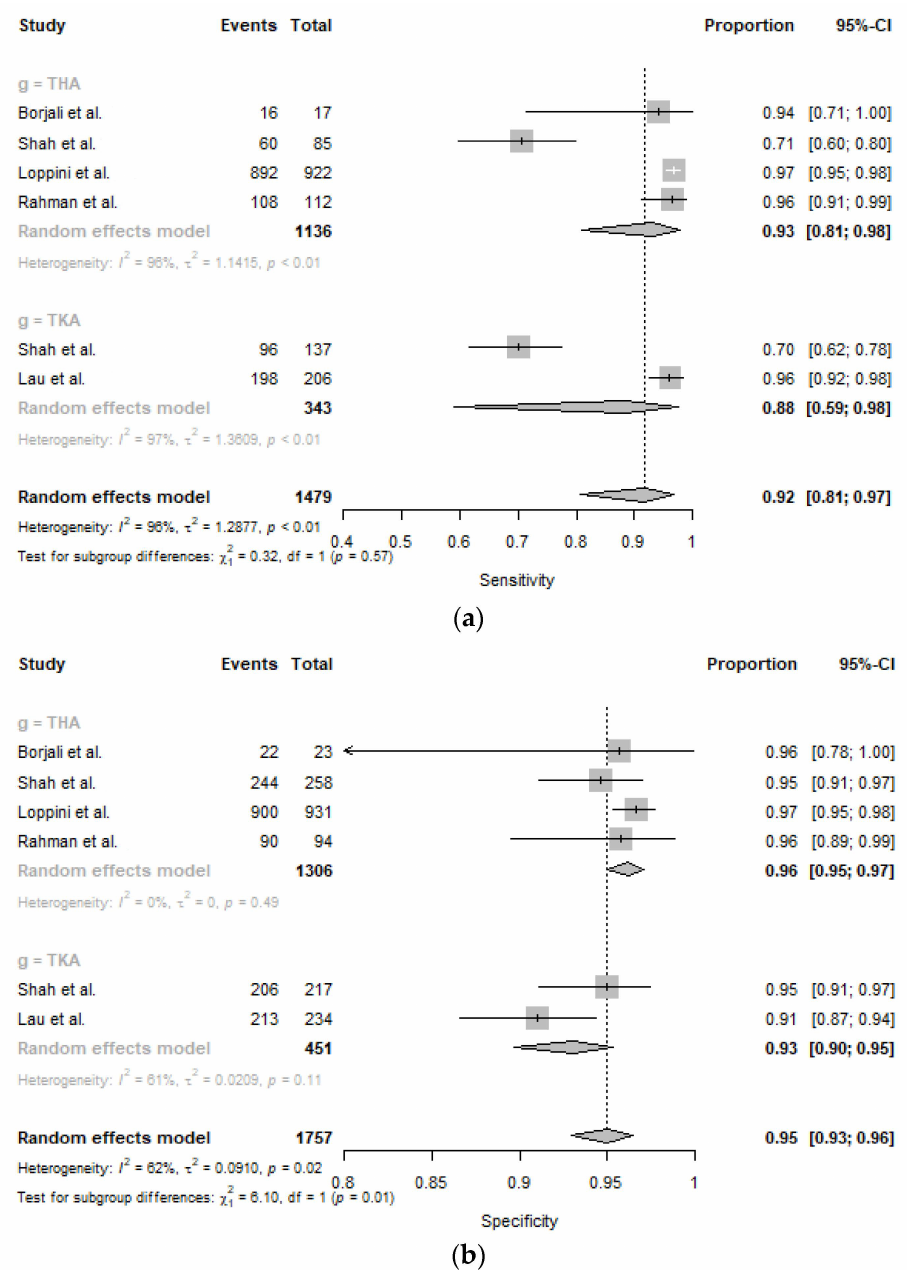
Figure 2. Forest plots for sensitivity ( a ) and specificity ( b ). GLMM: generalized linear mixed model, CI: confidence interval, THA: total hip arthroplasty, TKA: total knee arthroplasty